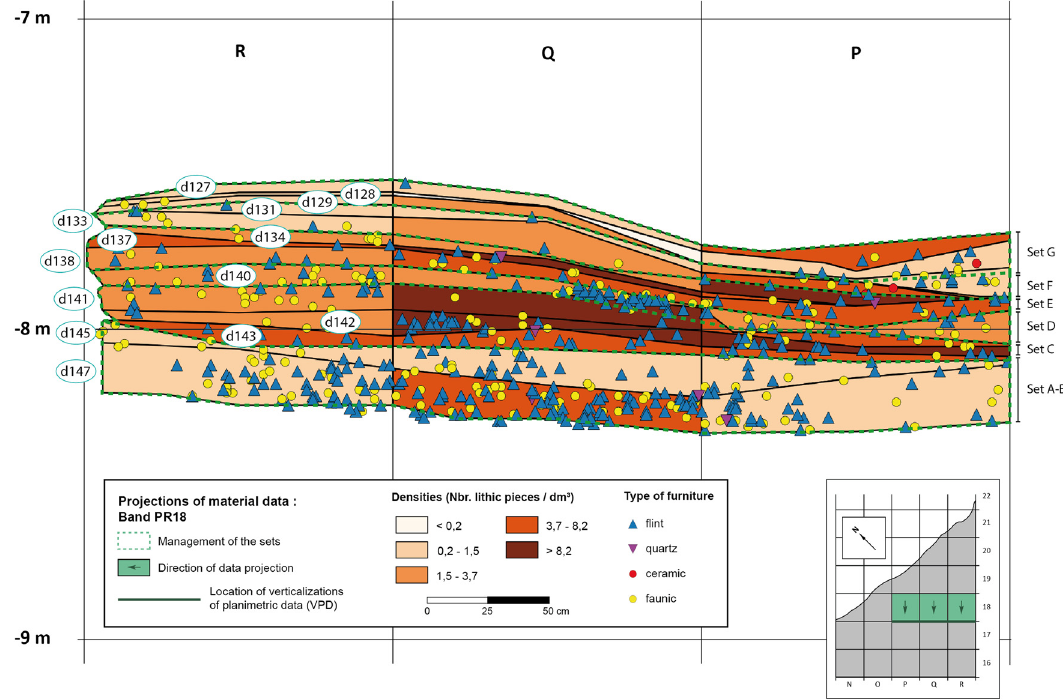
Figure 8: VPD on the PR18 axis displaying the density of lithic furniture and the vertical projection of lithic, faunal and ceramic remains ( from decapage d127 to d147 in the sector NR16 - 21 of La Grande Rivoire rockshelter )